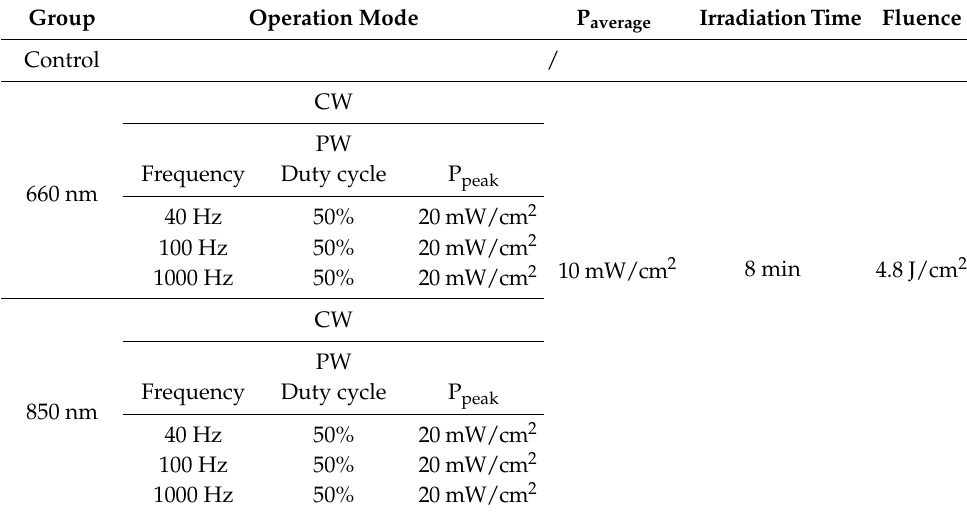
Table 3. Experimental conditions for frequency experiment.